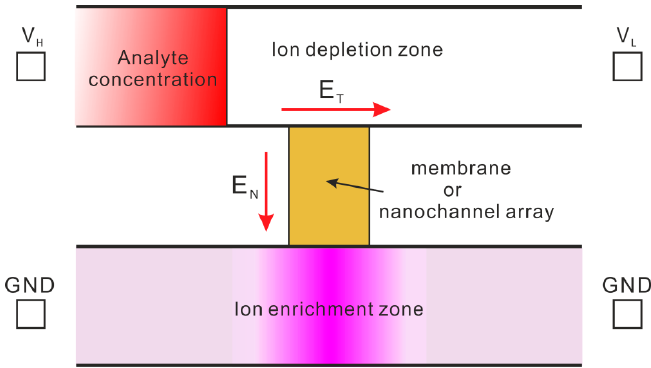
Figure 7. Schematic illustration of a typical electrokinetic trapping (EKT) concentration device. The device consists of two microchannels that are connected by a nanopore membrane or nanochannel array. Under the effect of applied voltages, ion concentration polarization is developed at the membrane-microchannel interfaces, giving rise to the development of an ion enrichment zone inside the lower channel and an ion depletion zone inside the higher channel. The ion depletion zone does not allow the passage of any charged species, thereby leading to the accumulation of charged analytes in front of the ion depletion zone.